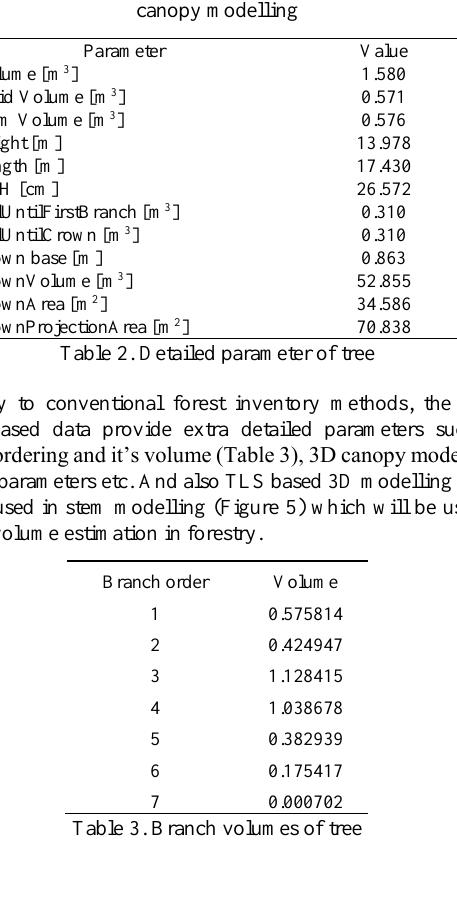
Figure 4. Extraction of branching order and tree components a) main branching order, b) first principle component, c) second principle component, d) third principle component e) 3D